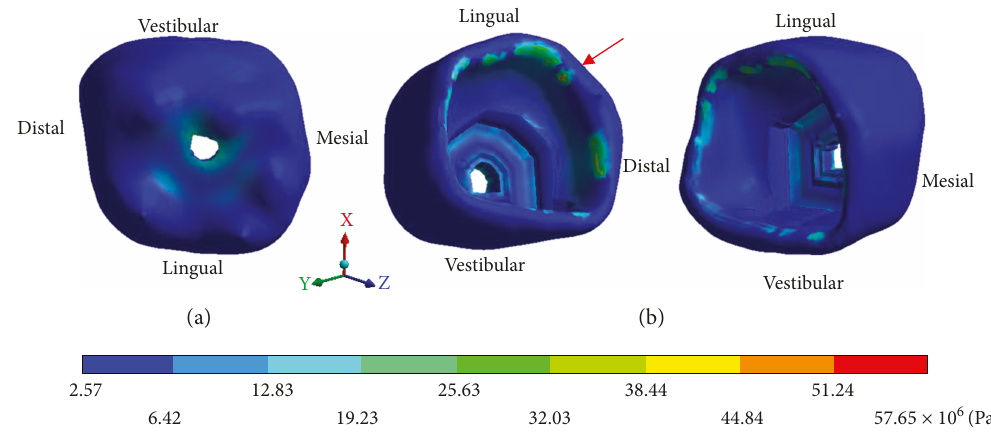
Figure 18: 4th degree caries : von Mises stresses in enamel: (a) occlusal view (b) cervical view.